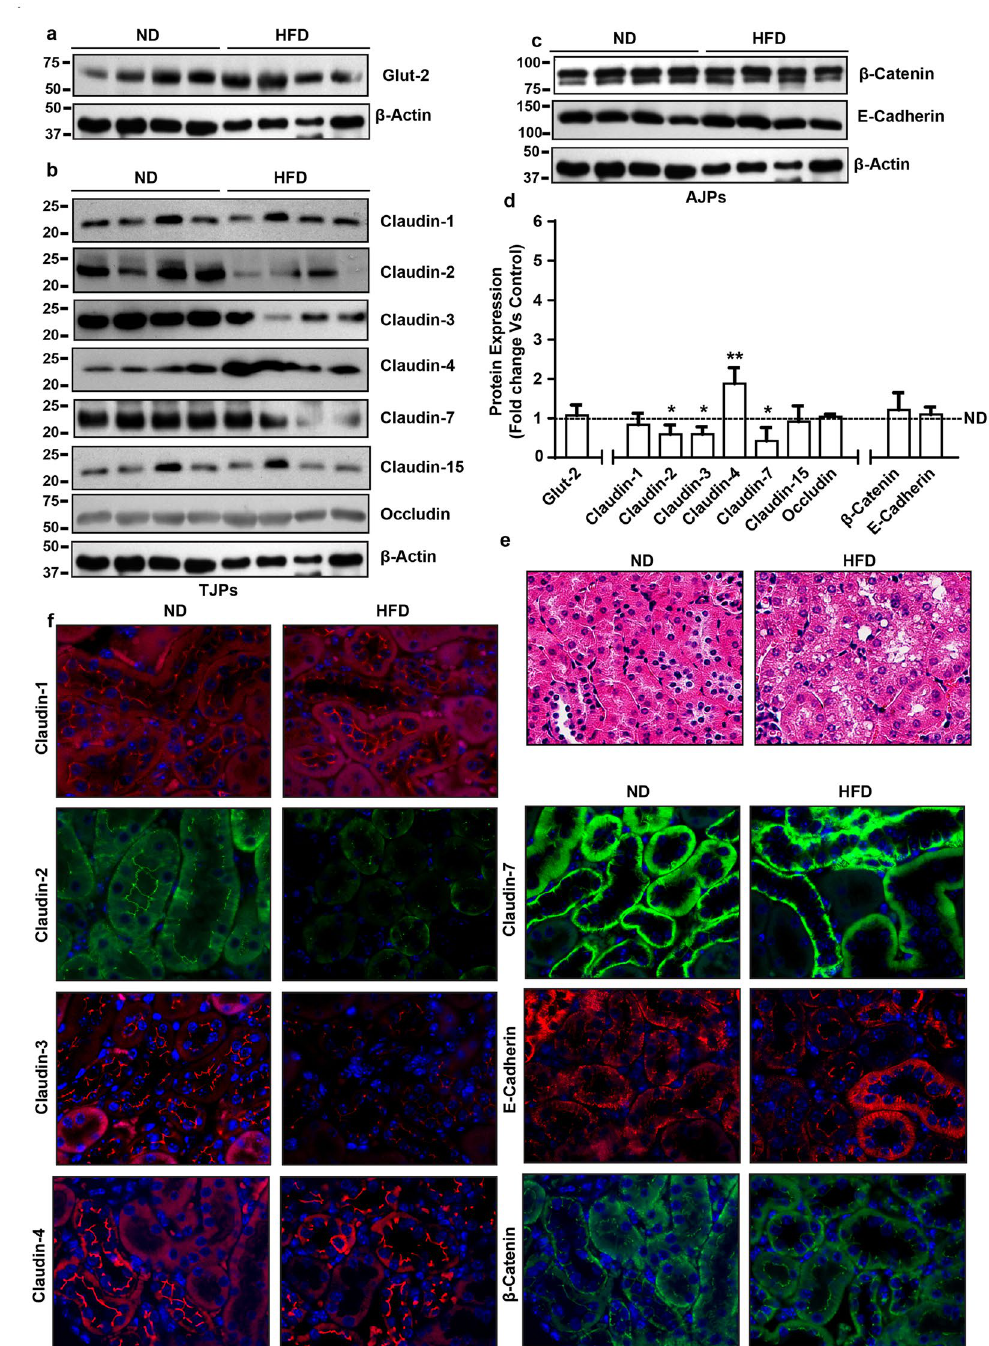
Figure 4. High fat diet induces contrasting (versus gut) changes in tight junction composition in renal epithelium: Immunoblot analysis of total tissue lysate prepared using the kidney from ND- and HFD-fed mice (N = 4). ( a ) Glut-2 expression in HFD and ND-fed mice, as positive control; ( b ) Immunoblot analysis to determine changes in TJPs using antigen-specific antibodies; ( c ) Immunoblot analysis to determine changes in AJPs including E-cadherin and β -catenin; ( d ) Quantitative analysis of immunoblot band intensity for respective protein; ( e ) Representative immunofluorescent images of specific TJPs using kidney sections from HFD- and ND-fed mice. Values are presented as mean ± SEM *** P ≤ 0.001; ** P ≤ 0.01 and * P ≤ 0.05 compared to control (normal chow fed mice; ND)